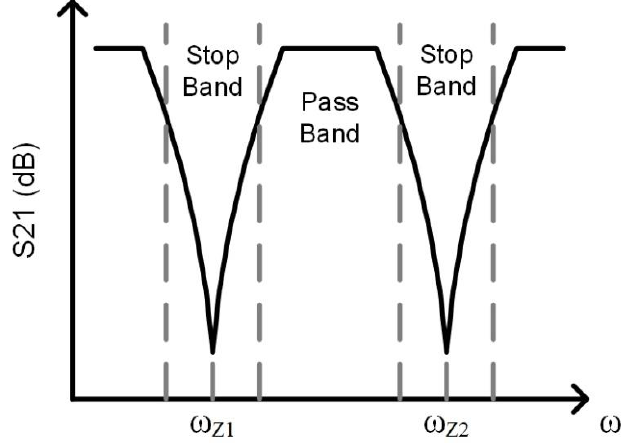
Figure 1. Illustration of how to form a passband by using two transmission zeros.